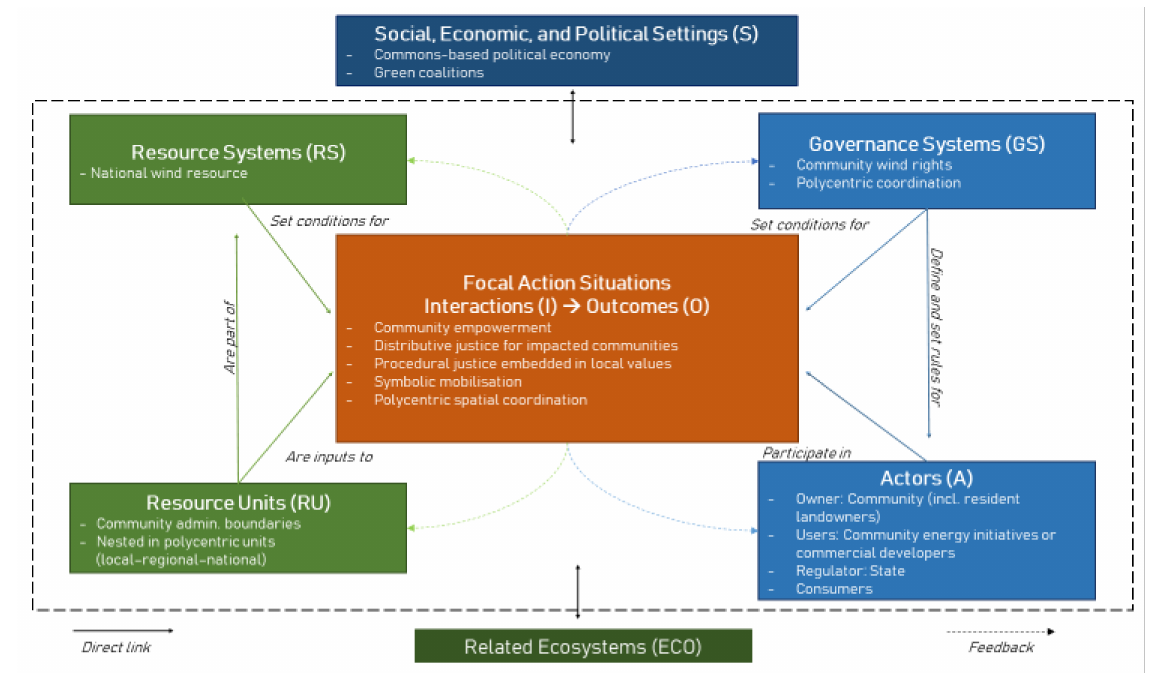
Figure 5. Scenario 3: Social-ecological model for wind energy under community-owned wind rights nested in polycentric governance. Source: authors, based on Ostrom’s SES